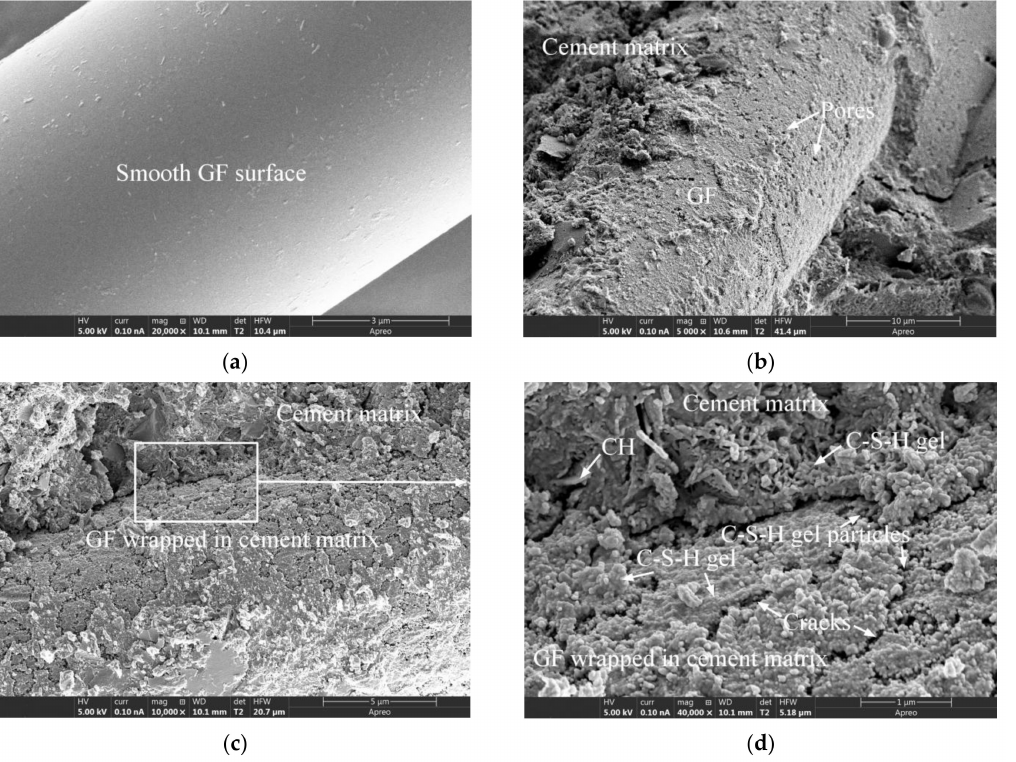
Figure 8. The SEM images of GF and GFRC specimens: ( a ) The unused GF; ( b ) GF-30-135; ( c ) GF-35- 135; ( d ) GF-35-135.